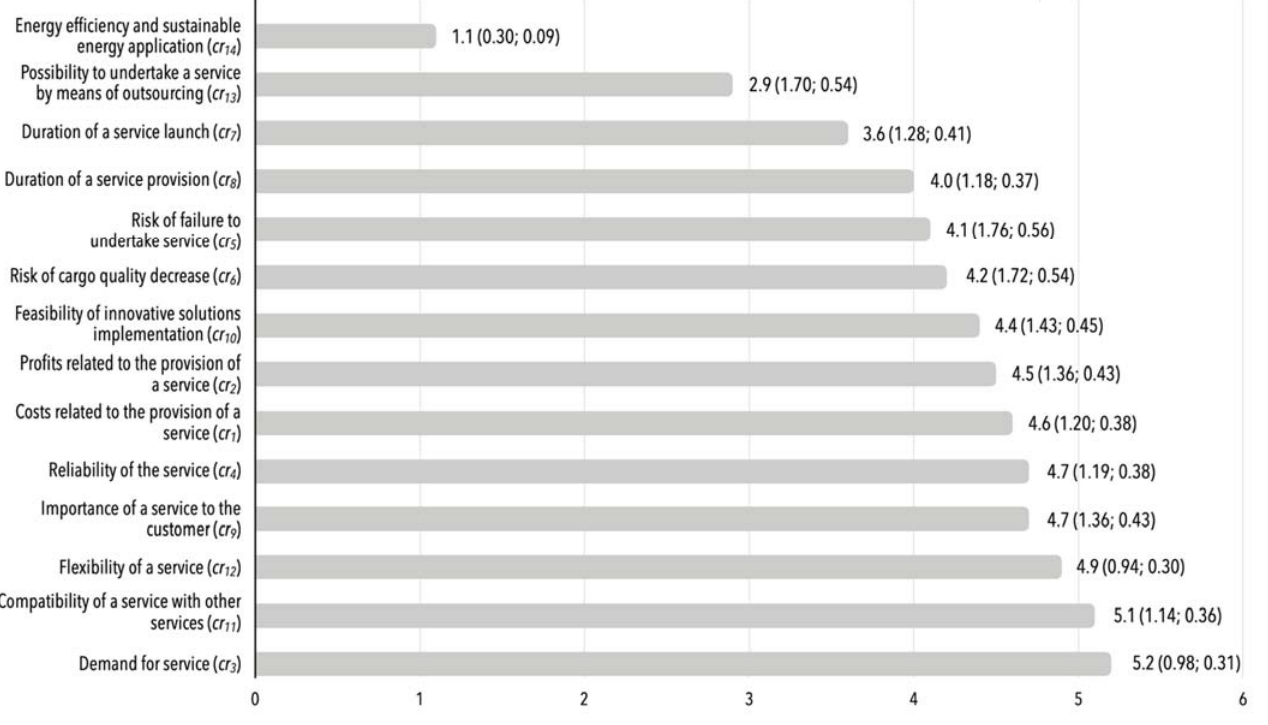
Figure 6. The ranking of importance of the criteria shaping the evaluation rules for including services in a transshipment terminal offering (the mean value for all the answers related to certain assessment criteria is given each time before parenthesis, the standard deviation and the mean squared error of the mean value are given each time in the parentheses, separated by a semicolon). Table 4. The customer assessment of criteria shaping given in